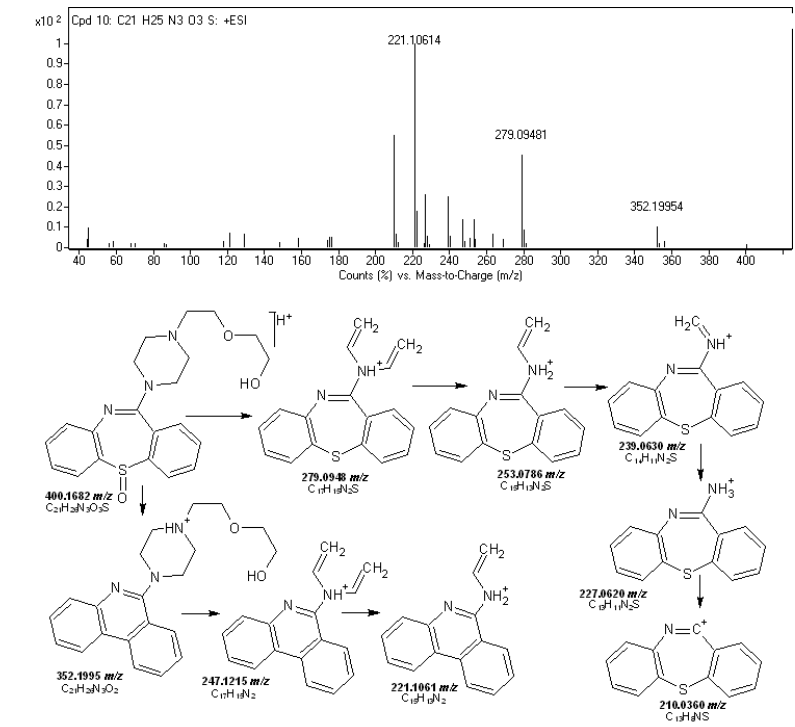
Figure 3. Q-TOF MS/MS spectrum and fragmentation pathway of photodegradation product D1 ( t